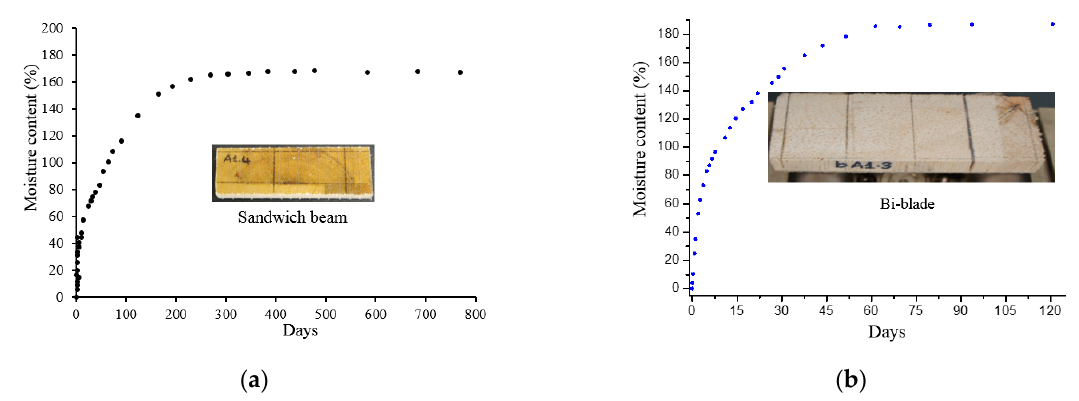
Figure 4. Diffusion kinetics of moisture at 40 °C in a sandwich beam ( a ) and a bi-blade (one skin and Figure 4. Di ff usion kinetics of moisture at 40 ◦ C in a sandwich beam ( a ) and a bi-blade (one skin and a a core) ( b ). core) ( b